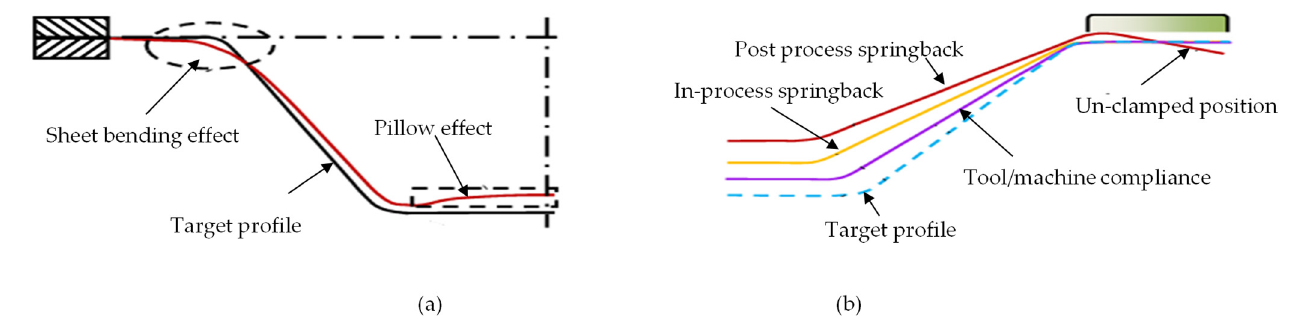
Figure 10. ( a ) Geometric error (reprinted with permission from Micari et al. [44], Copyright 2007 Elsevier). ( b ) Wall region error detail.